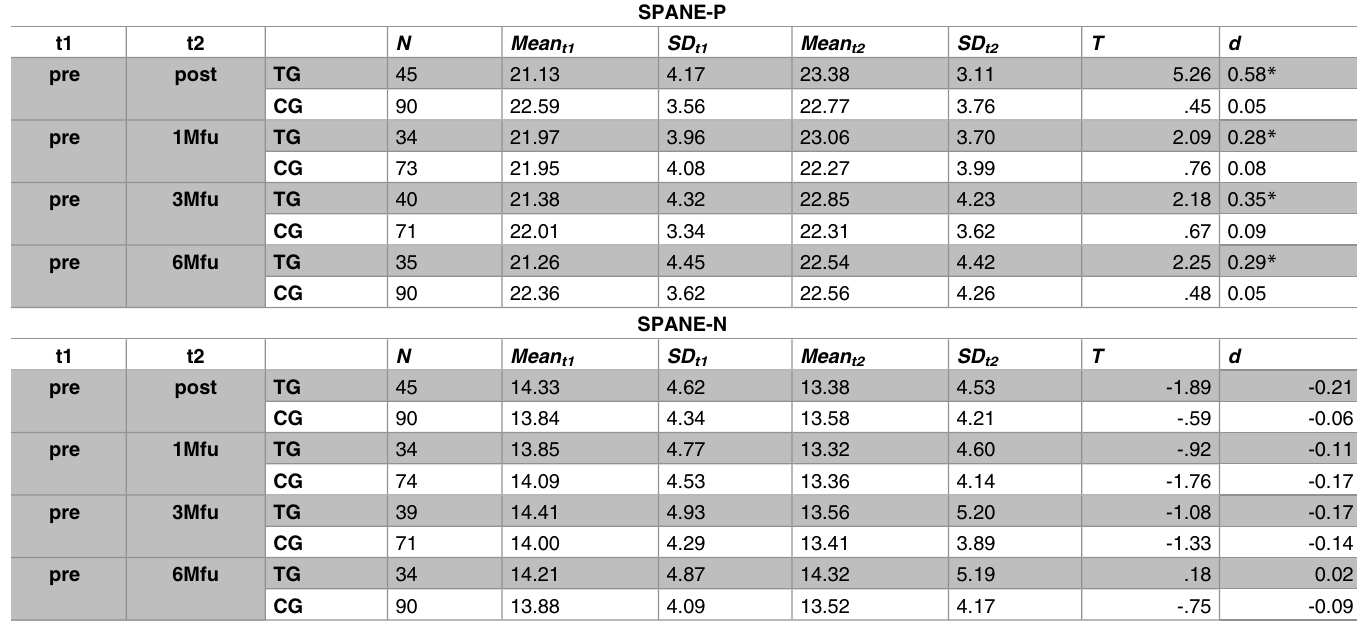
Table 6. SWB-Training-Evaluation with the